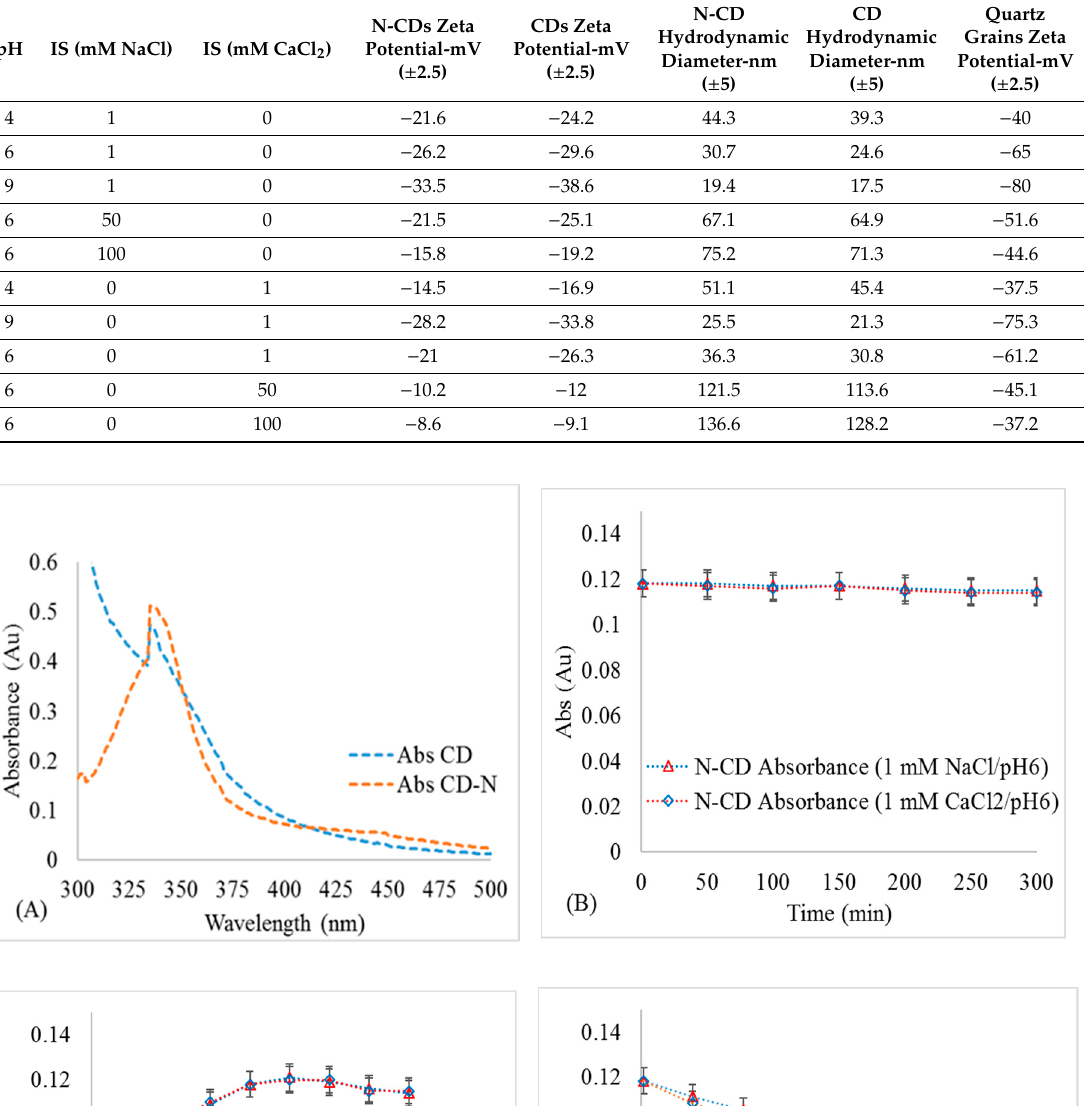
Table 1. Zeta potential for nitrogen functionalized carbon dots (N-CDs) and sand grains at di ff erent